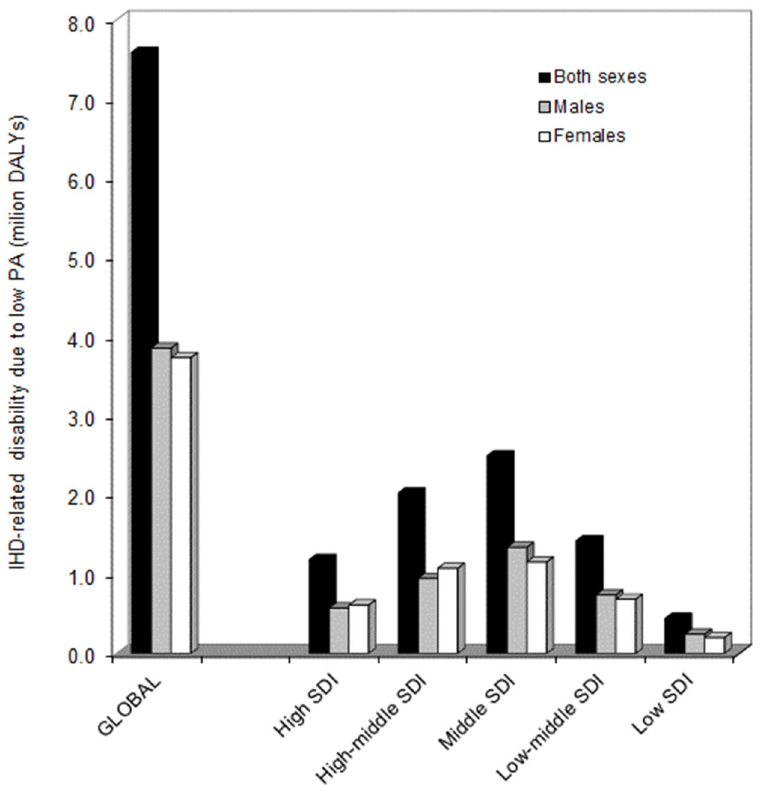
Figure 1. Ischemic heart disease ‐ related impairment that could be attributed to low physical activity in 2019, based on data from the Global Health Data Exchange (GHDx) 2019 repository. DALYs, disability ‐ adjusted life years; IHD, ischemic heart disease; PA, physical activity; SDI, socio ‐ demographic index.